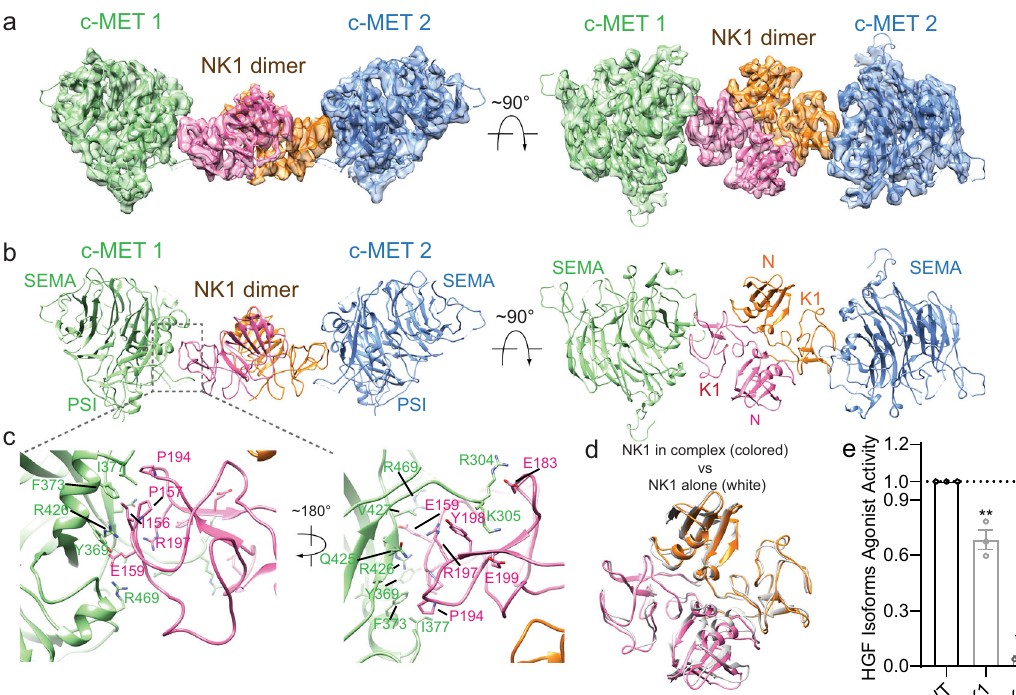
Fig. 6 Overall structure of the c-MET/NK1 complex. a 3D reconstruction of the 2:2 c-MET/NK1 complex, and the corresponding ribbon representation of this complex fi tted into the cryo-EM map at 5 Å resolution, shown in two orthogonal views. b The ribbon representation of the 2:2 c-MET/NK1 complex shown in two orthogonal views. c Close-up view of the interface between c-MET-SEMA and HGF-K1, showing in two views. d Superposition between free NK1 dimer (PDB ID: 1NK1 44 ; white) and NK1 dimer after binding c-MET (colored). e The levels of c-MET autophosphorylation in response to NK1 or NK2. Mean± SEM are from N = 3 independent biological repeats. Statistical difference was analyzed using two-tailed Student ’ s t -test and P values were calculated between WT and mutants: ** P ≤ 0.01; *** P ≤ 0.001. The representative western blot data were shown in Supplementary Fig. 5. Source data are provided as a Source Data fi le. Exact P values in e from left to right: 0.0043,